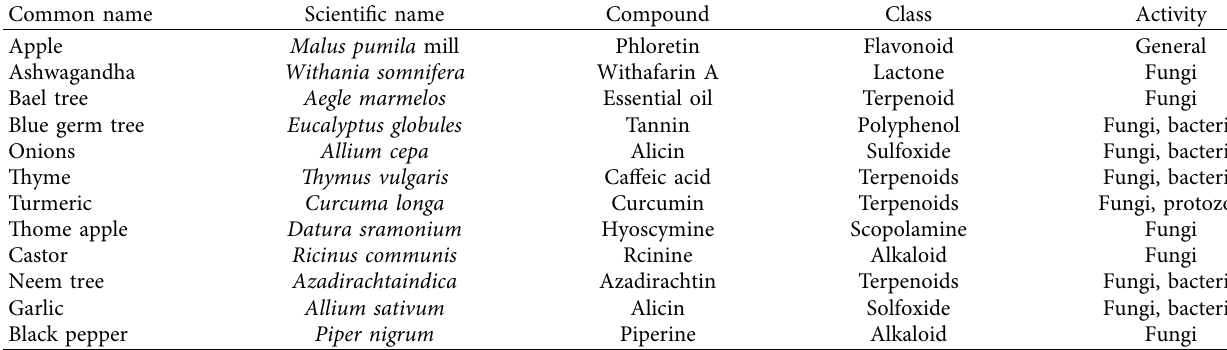
Table 3: Botanicals with antimicrobial activities.